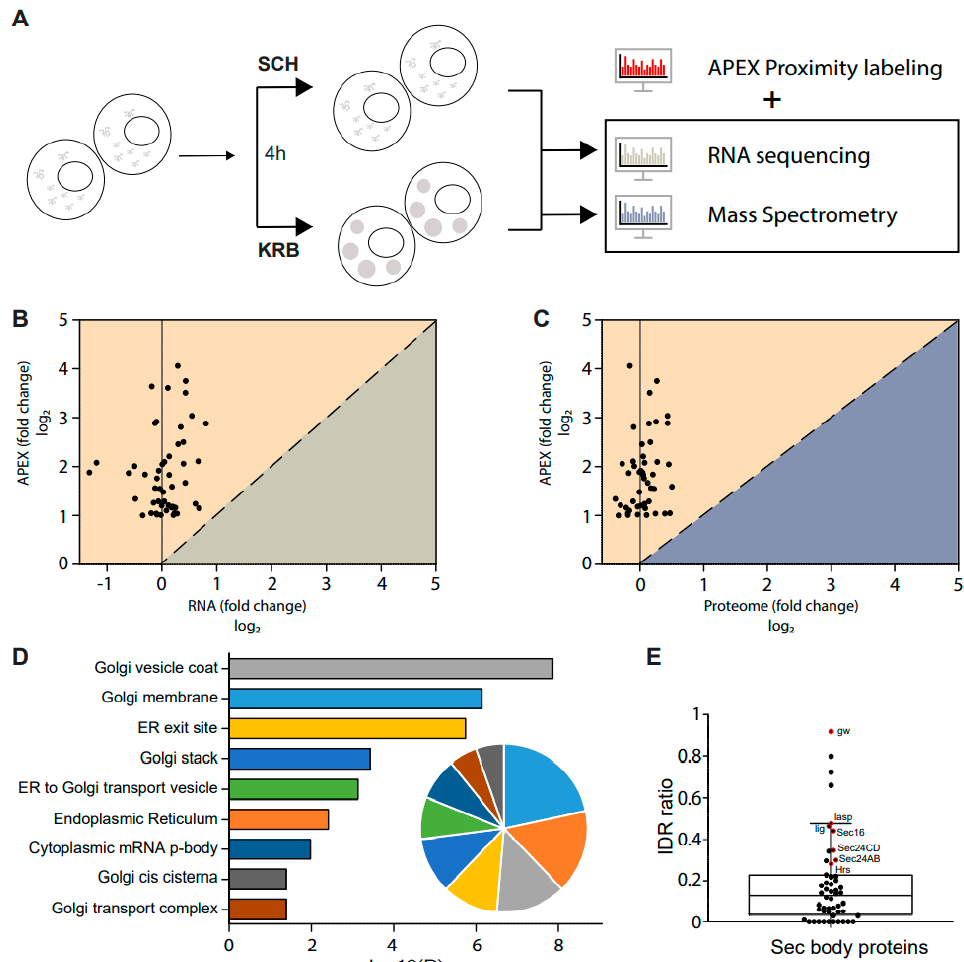
Figure 4. Sec body formation depends on the re-localization of existing cytosolic proteins. ( A ) Schematic of combined RNA, protein and APEX analyses of KRB-treated cells. Differential changes at 4 h starvation, if any, were analyzed for correlative trends. ( B , C ) Correlation between significantly enriched Sec body proteins and the respective transcript levels ( B ), or total proteome levels ( C ). Almost all proteins that accumulate in Sec bodies were not differential at the RNA or total proteome level. ( D ) Bar graph depicting significantly enriched gene ontology cellular compartment (GO/CC) terms for proteins in Sec bodies, as calculated by DAVID. The pie graph inset shows the relative proportion of Sec body proteins annotated to these cellular compartments. A large majority of Sec body proteins are of ER and Golgi origin. ( E ) Box scatter plot showing 52 Sec body proteins ranked by the proportion of intrinsically disordered region (IDR). Proteins annotated in red were significantly enriched in Sec bodies, as indicated by black side bar in the heatmap in Figure